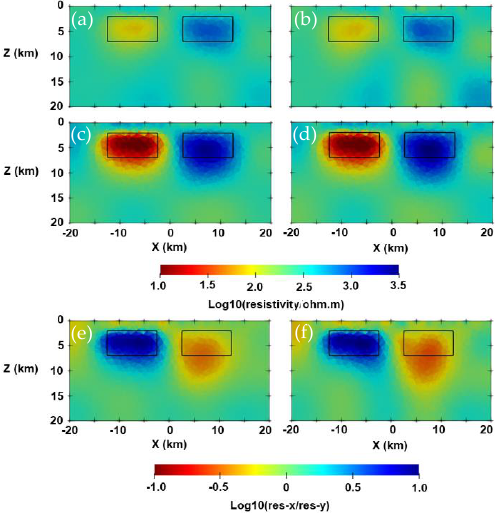
Figure A1. Anisotropic inversion results at y = 0 km. Panels ( a ) and ( b ) show the inverted resistivity in the principal X direction for 𝐖 𝑑 with nonuniform and uniform data variance. Panels ( c ) and ( d ) show the inverted resistivity in the principal Y direction for 𝐖 𝑑 with nonuniform and uniform data variance. Panels ( e ) and ( f ) show the inverted anisotropic coefficient for 𝐖 𝑑 with nonuniform and uniform data variance.